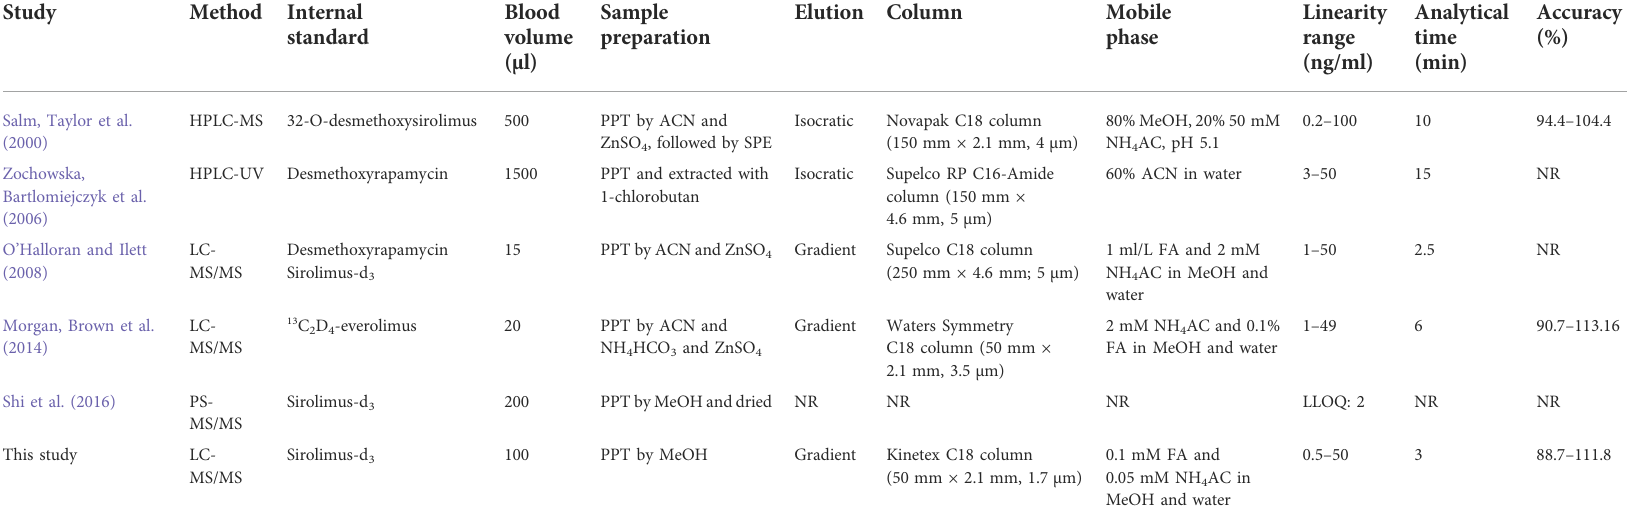
TABLE 1 Comparison of this study with several previously published analytical methods for